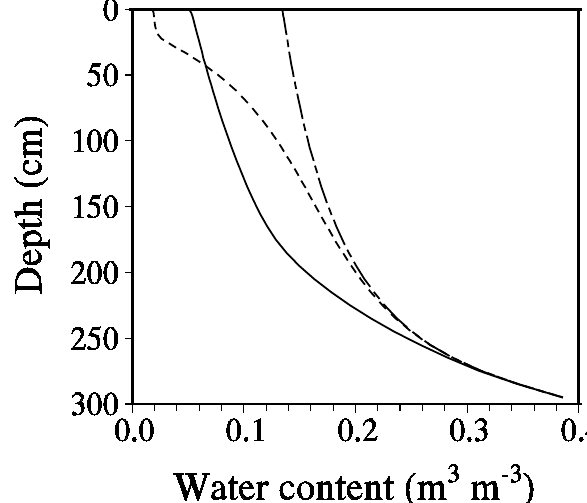
Fig. 7. Water content profiles for a sandy soil (Table 1) after a 100 day dry-down period with a water table at 3m depth, simulated with uptake compensation (Eqs. 1 to 4 and 17, solid line) and without (Eqs. 14 and 19, dashed line). The dashed-dotted line shows the initial water